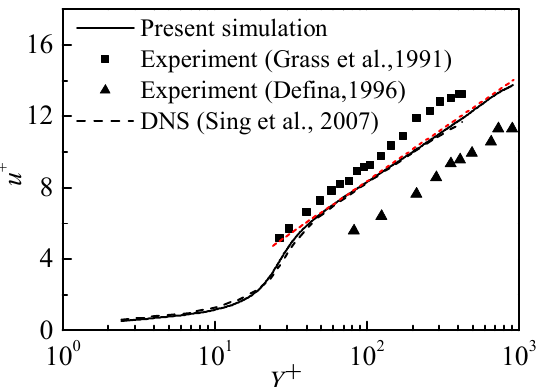
Figure 2. Mean velocity profiles. The red short-dashed line indicates the fitted velocity profile according to the logarithmic law-of-the-wall [45,55,56].